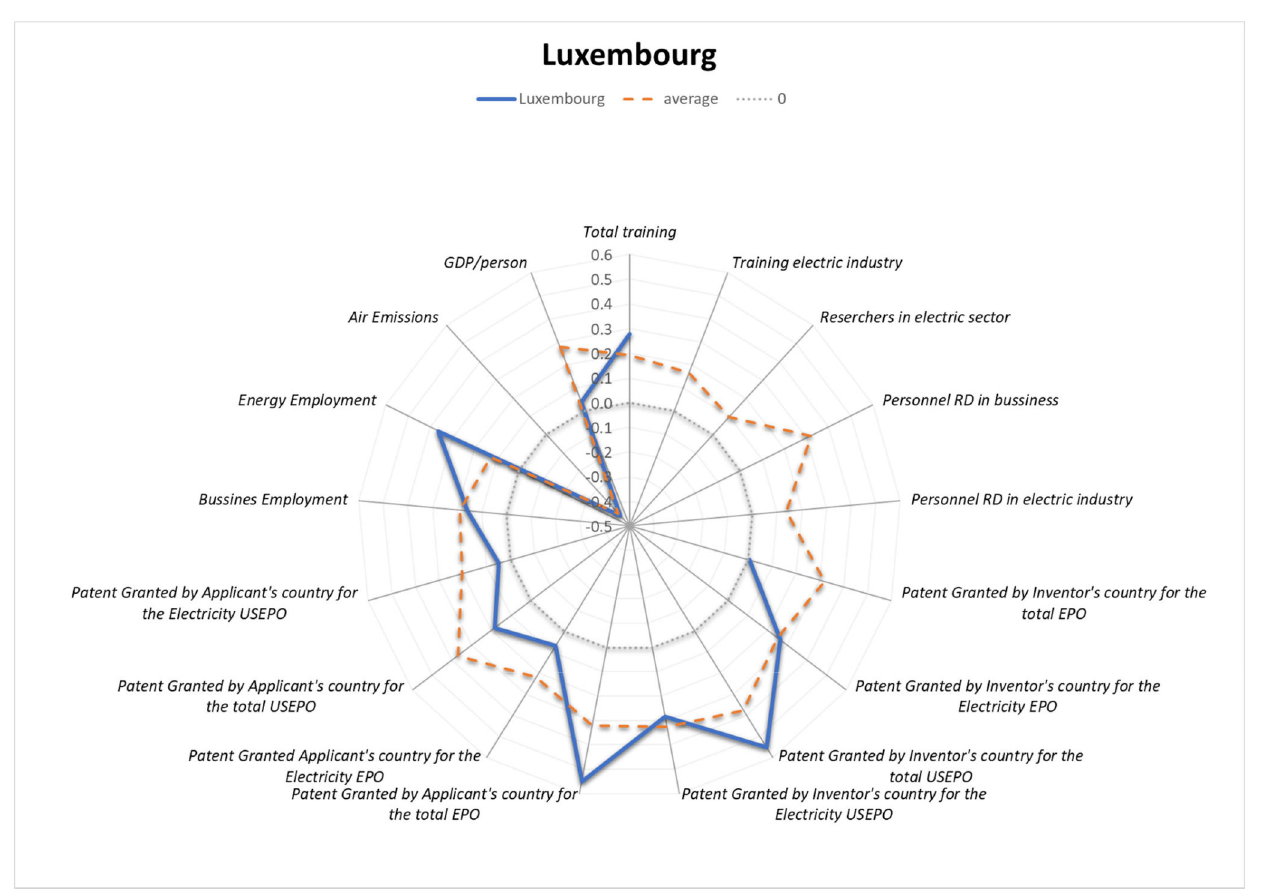
Figure 26. Synergy and trade-off occurrence—LU. Source: Authors’